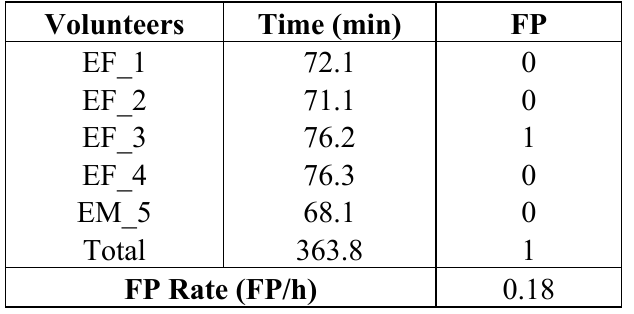
Table 7. The FP number for the subjects of Table 1 Set 2 in the continuous unscripted ADL without falling activities in the experiment.